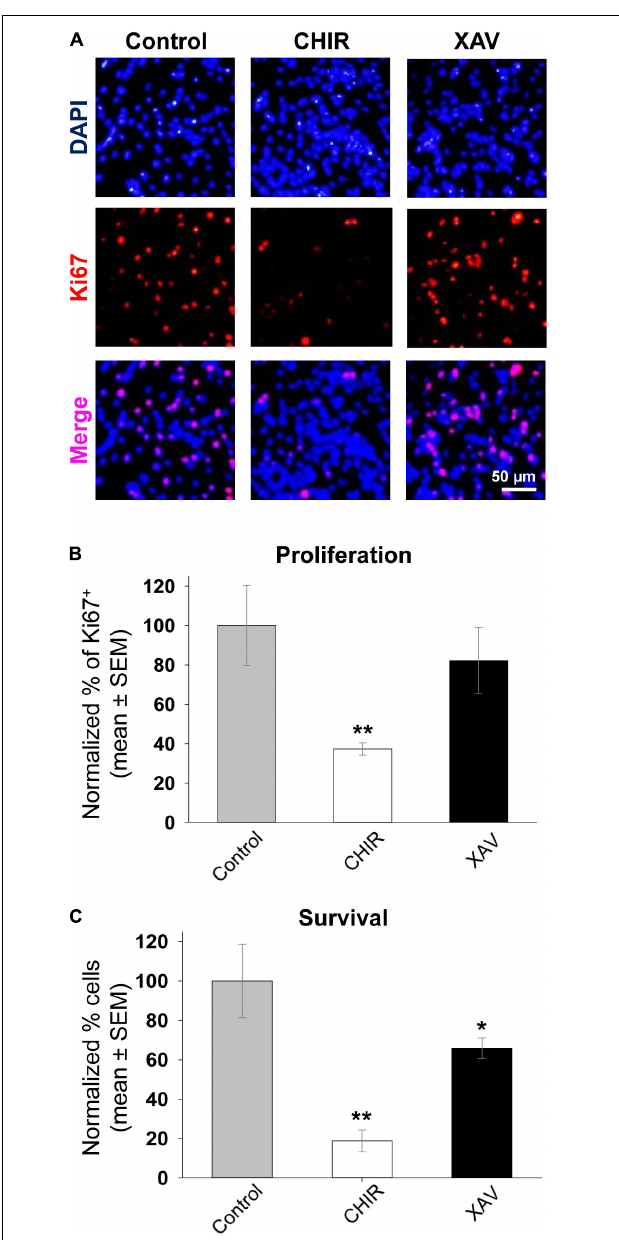
FIGURE 3 | Effect of Wnt modulators on proliferation and survival of hNPCs. (A) Representative images of fixed HUES-6 hNPCs in control conditions (NIM + bFGF) and after 7 days of treatment with 3 µ M CHIR or XAV, stained with the nuclear dye DAPI ( top row , blue) and immunostained with the proliferation marker Ki67 ( middle row , red). Bottom row shows the merged images of DAPI and Ki67 double staining (pink). (B) Proliferation rate quantified as the percentage of Ki67-positive cells from the total number of cells (DAPI-positive), in control conditions (gray bar) and following hNPCs exposure to 3 µ M of CHIR (white) or XAV (black) for a total of 7 days. Experiments were repeated three times in all 4 hNPC lines, 3 random fields were imaged and analyzed in each experiment. Quantification was conducted post hoc using ImageJ ROI tool. Values are shown as mean ± SEM, normalized to control. * p < 0.05; ** p < 0.01, ANOVA. (C) Survival assay conducted on hNPCs after 7 days of control conditions (gray bar) or